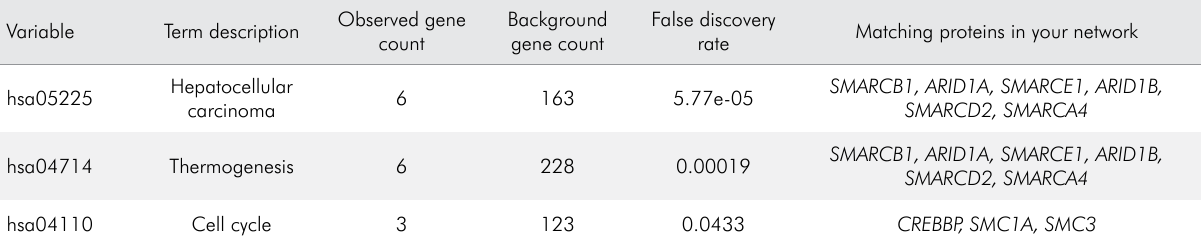
Table 4. Activated pathways characterized with syndromes with hypertrichosis and dental anomalies-containing-genes.